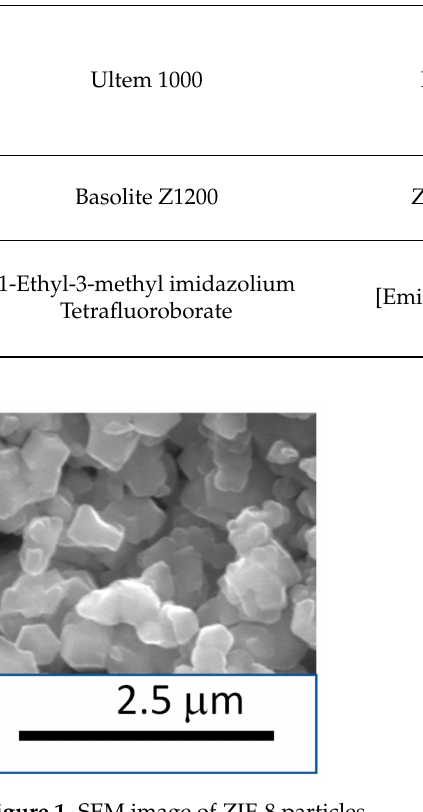
Figure 1. SEM image of ZIF-8